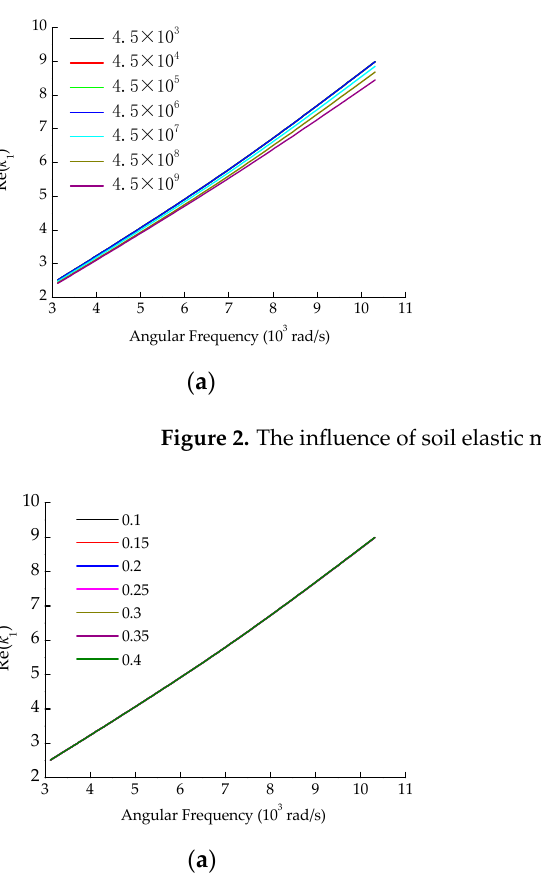
Figure 1. The influence of soil density on wavenumber. ( a ) Real part; ( b ) Imaginary part.